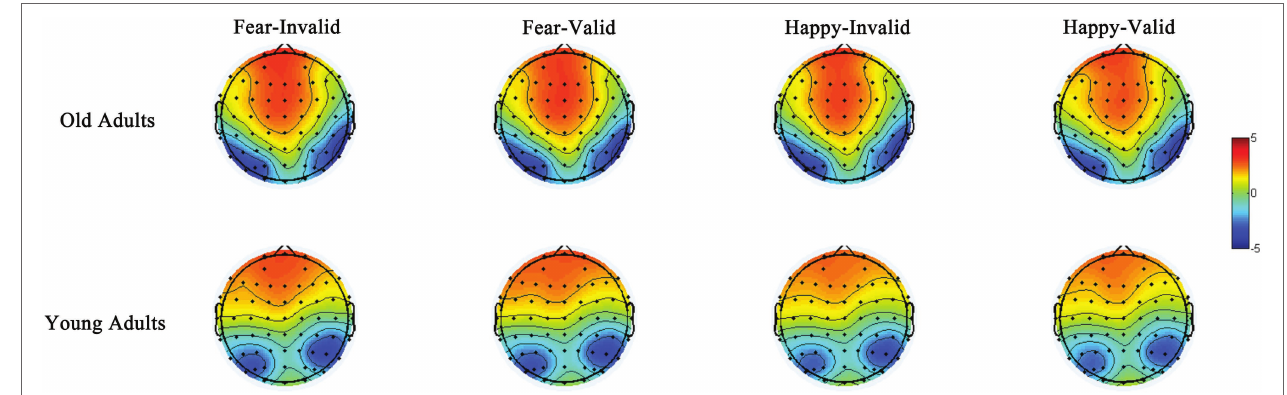
FIGURE 5 | The topographic maps for N170 for both old and young groups for four conditions: Fear – Invalid, Fear – Valid, Happy – Invalid, Happy –